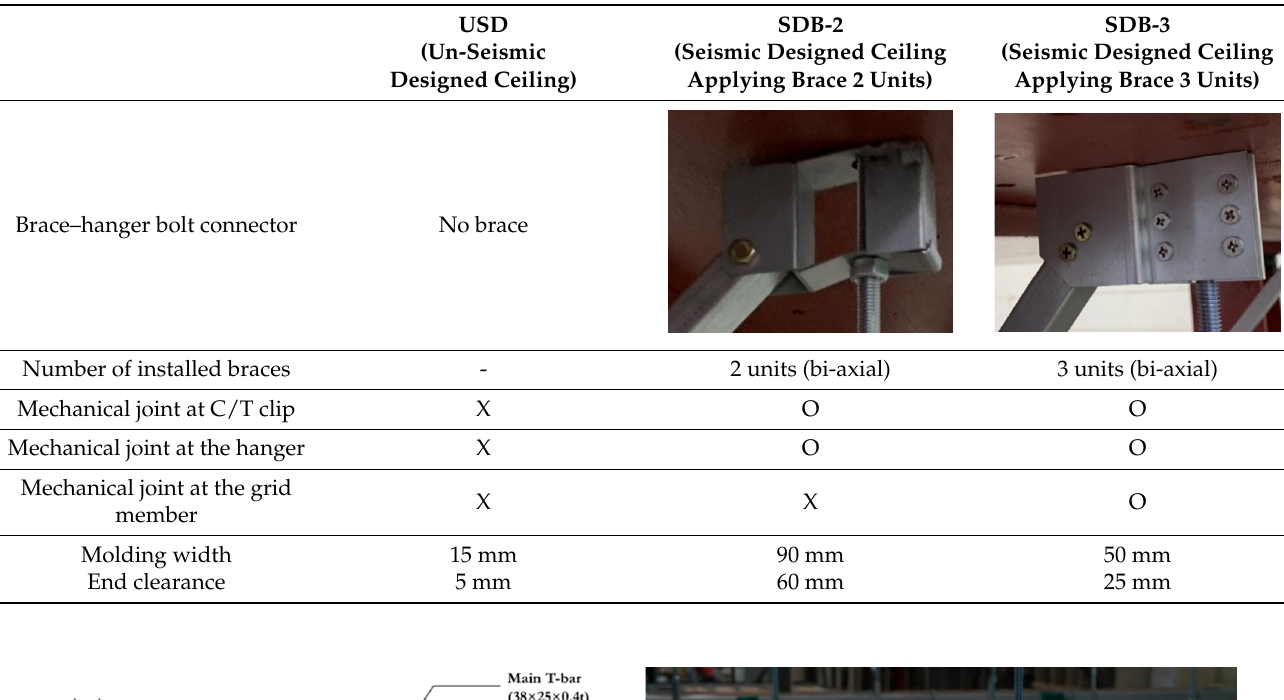
Table 2. Information of the specimens.